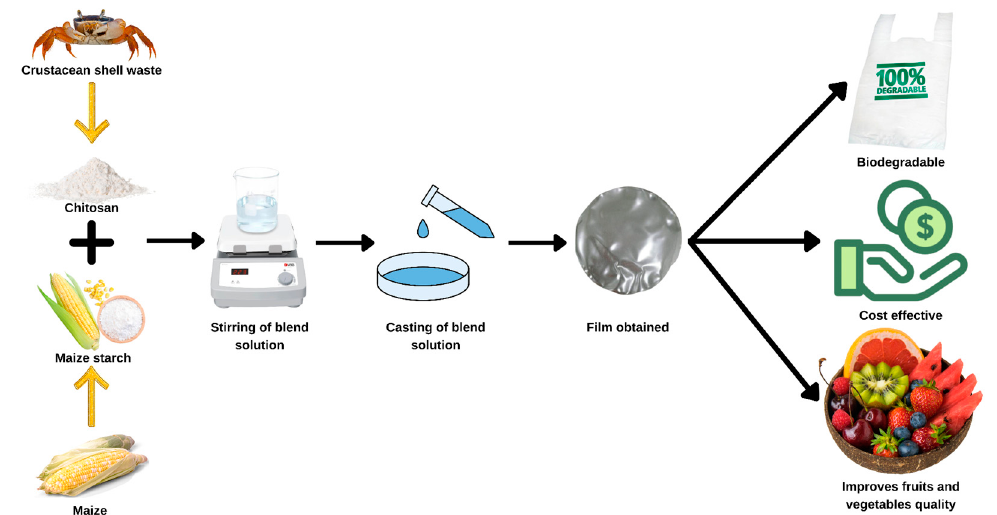
Figure 3. Illustration of biodegradable packaging. Table 1. Application of biodegradable film in food products.